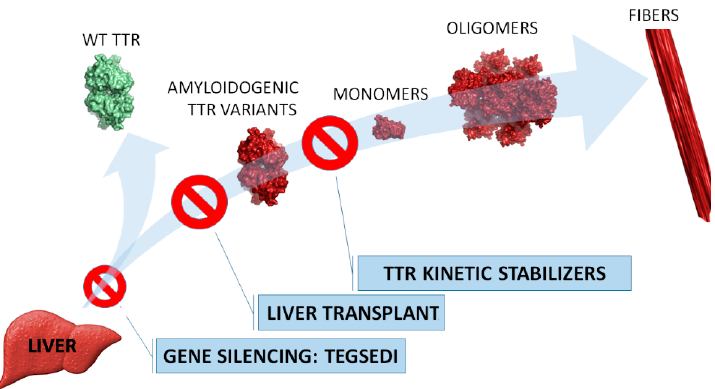
Figure 1. Strategies to prevent transthyretin (TTR) amyloidosis. Liver transplant is the standard practice since TTR (an amyloidogenic variant in familial amyloid polyneuropathy (FAP) patients) is mainly produced in the liver. Tegsedi inhibits hepatic production of TTR (both wild-type and amyloidogenic variants). TTR kinetic stabilizers are compounds that selectively bind to TTR, preventing its dissociation (Tafamidis was approved in E.U.)